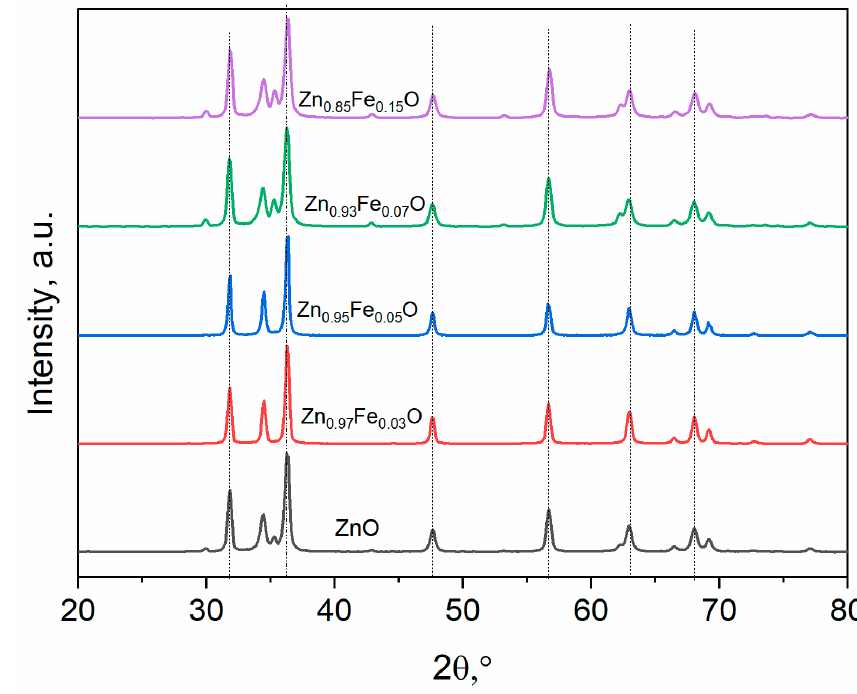
Figure 1. XRD patterns of Zn 1 − x Fe x O.